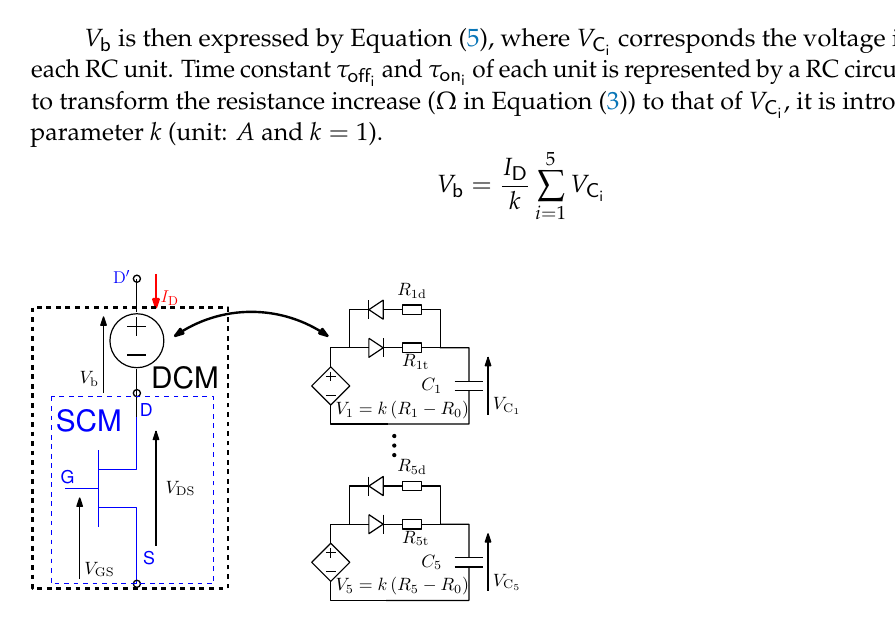
Figure 11. GaN-HEMT dynamic R DSon compact model.